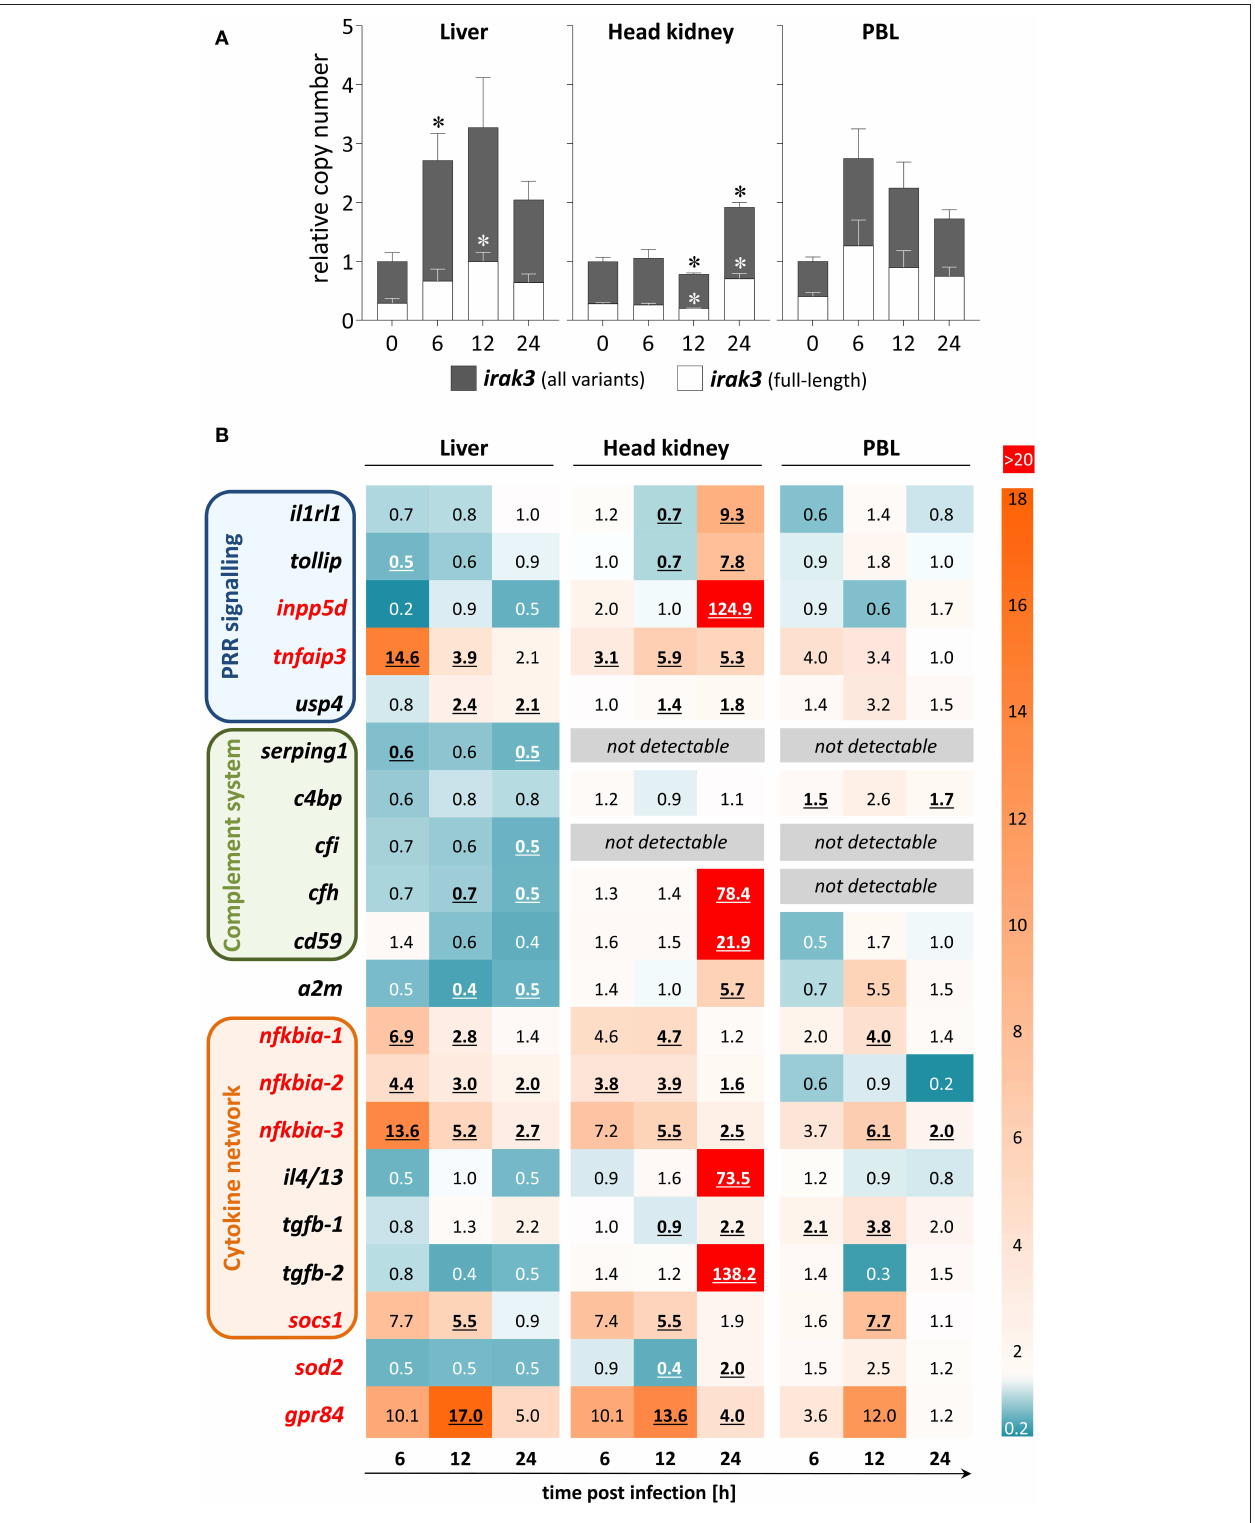
FIGURE 4 | Expression profile of regulatory immune genes during A.-salmonicida infection of rainbow trout. (A) We used discriminating primer pairs to determine the abundance of all irak3 variants in trout (filled columns) and the proportion of the full-length irak3 transcripts (open columns) in the liver (left panel), head kidney (central), and PBLs (right) of four individuals at the various time points after infection relative to uninfected fish (0h; set as 1.0). Significant copy-number changes